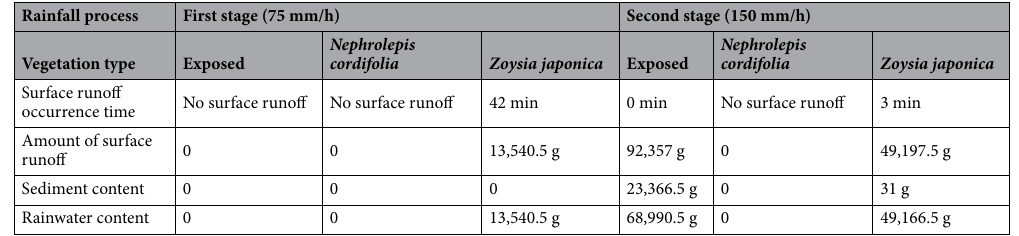
Table 4. Surface runoff statistics.